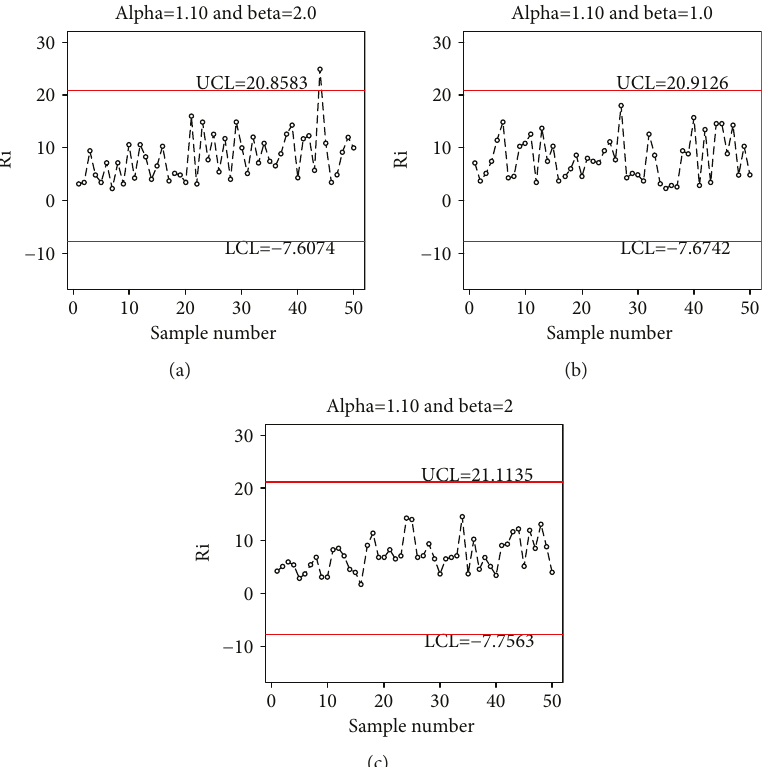
Figure 1: The proposed control chart and existing charts using simulation data.